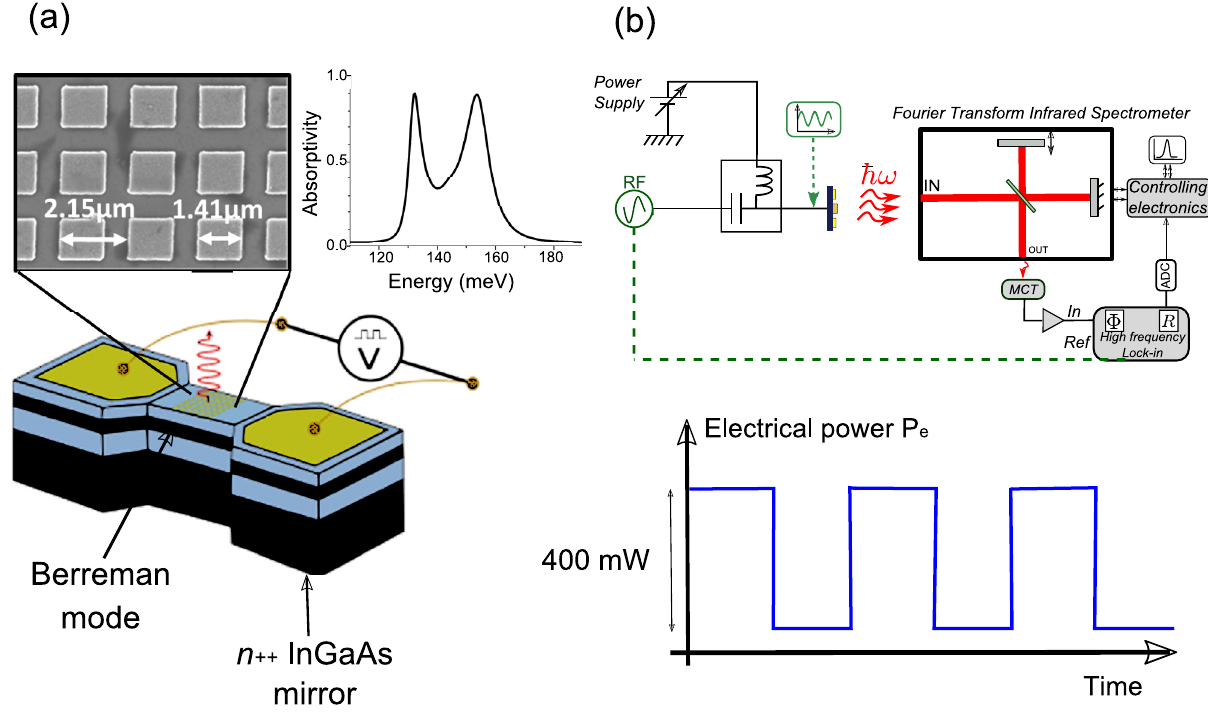
Figure 3: (a) Sketch of the device fabricated for thermal emission experiments. It consists of a 50 × 50 µm 2 mesa with a top grating for the extraction of incandescent emission. In order to electrically excite the thermal emission, two lateral Ti/Au contacts (125 × 100 µm 2 ) have been evaporatedontheGaInAslayersustainingtheBerremanmode,afterinductivelycoupledplasmareactiveionetching.Thetoppartofthepanel presents a scanning electron microscope image of the grating, with its characteristic dimensions, and the calculated absorption spectrum, displaying two polariton modes with almost unity peak absorptivity. (b) Sketch of the setup used for high frequency modulation of thermal emission. An electrical current is injected between the two lateral contacts. Its time modulation results in a modulation of the emitted